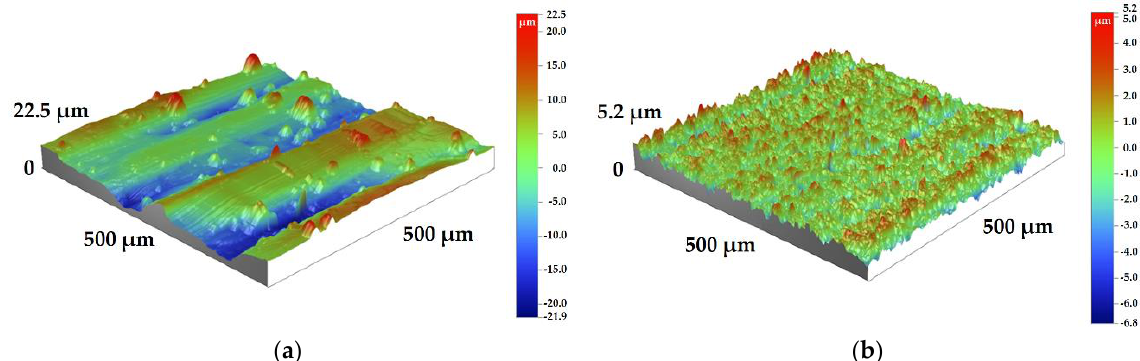
Figure 3. Topology of the laser additively produced part surface made of 12Cr18Ni9Ti austenite chrome–nickel stainless steel (analog of AISI 321) powder with granules of ≈20 µm (by a Dektak XT stylus profilometer (Bruker Nano, Inc., Billerica, MA, USA) with a vertical accuracy of 5 Å (0.5 nm) and a tip radius of 12.5 µm): ( a ) after production; ( b ) after vibratory tumbling.